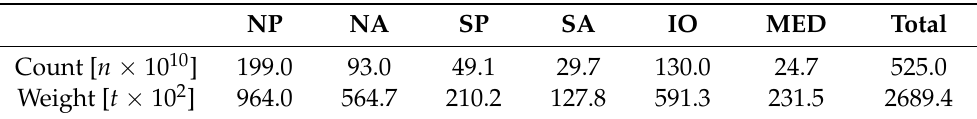
Table 1. Estimated count of plastic pieces (all size classes) and its weight floating in the oceans worldwide: North Pacific (NP), North Atlantic (NA), South Pacific (SP), South Atlantic (SA), Indian Ocean (IO), Mediterranean Sea (MED) (data from Eriksen et al. [5]). NP NA SP SA IO MED Total Count [ n × 10 10 ] 199.0 93.0 49.1 29.7 130.0 24.7 525.0 Weight [ t × 10 2 ] 964.0 564.7 210.2 127.8 591.3 231.5